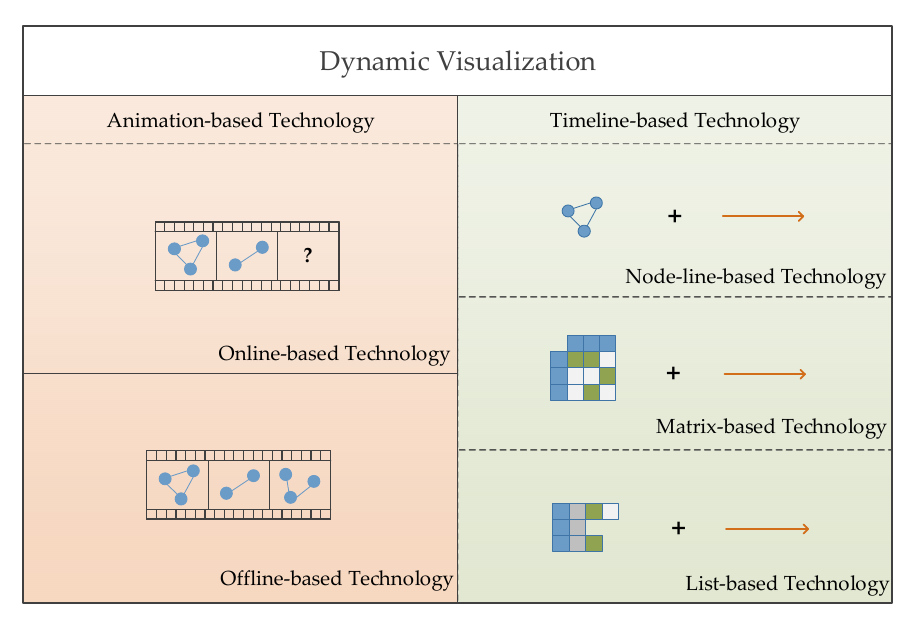
Figure 7. List of visualization methods.